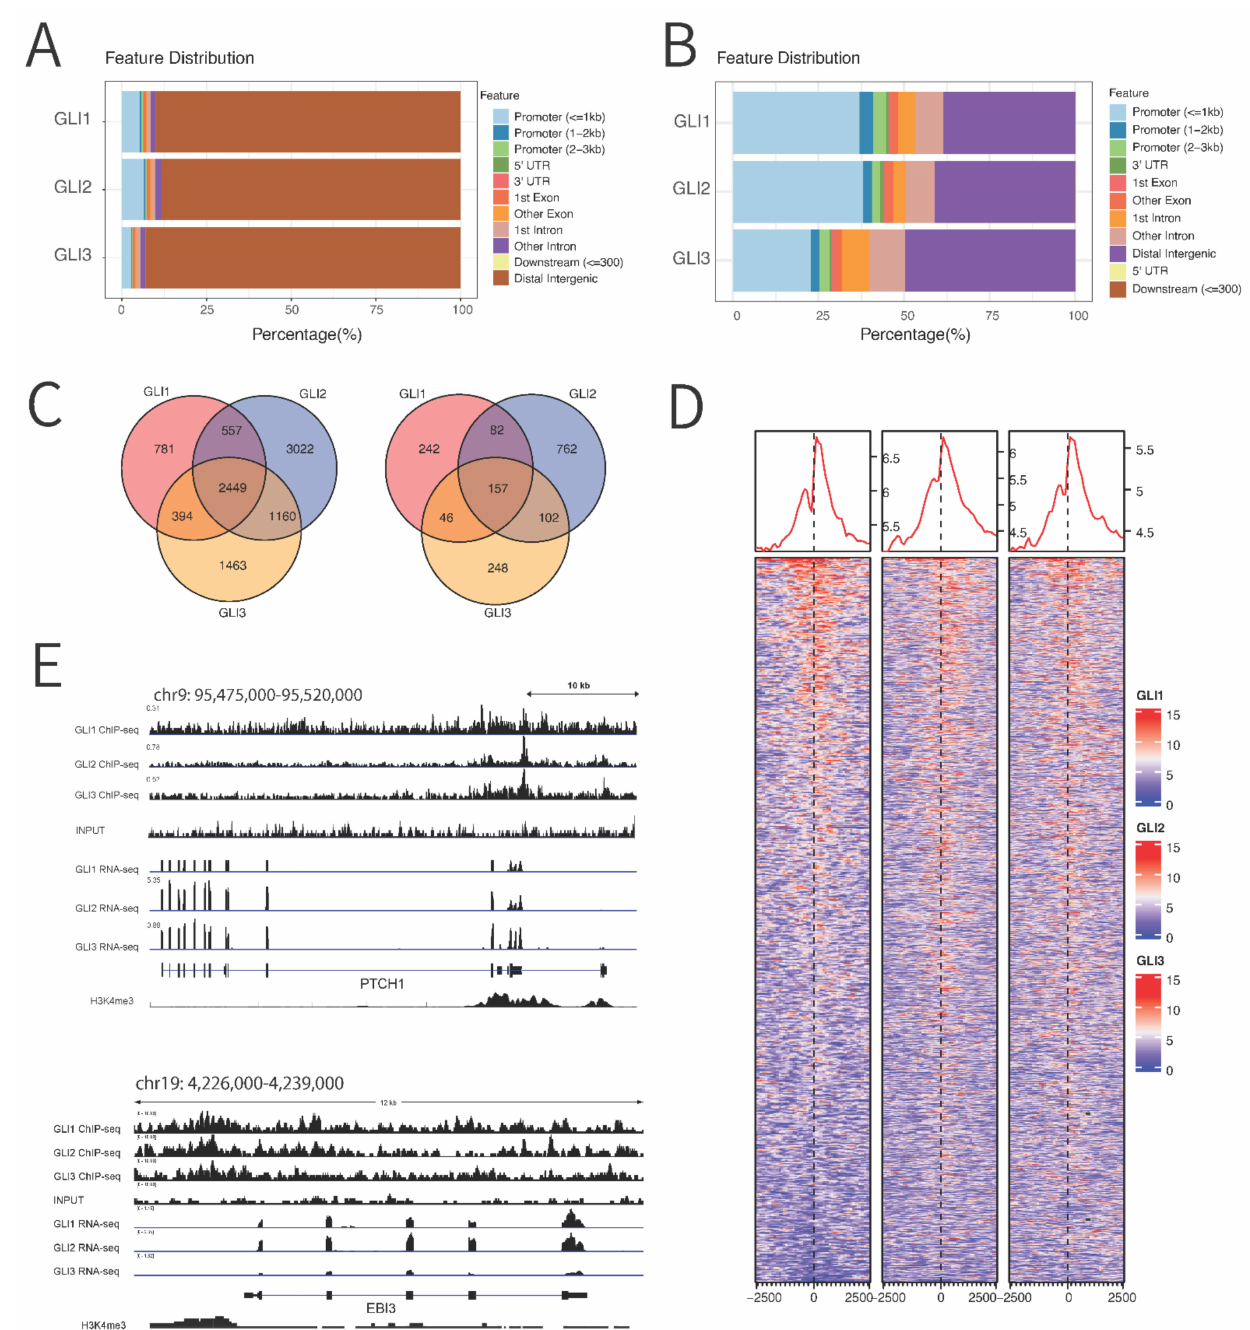
Figure 3. ChIP-seq analysis of GLI1-3 binding across cell lines. ( A ). Binding of peaks on the whole genome. ( B ) Binding of peaks that centered on the promoter regions ( C ) Overlap of GLI1-3 binding sites: left image shows overlapping of peaks on whole genome, and right image shows overlapping of peaks on the promotor regions only. FDR value vas set to 0.2. ( D ) Heatmap of binding of GLI1-3 TFs across promoter sites. ( E ) Peak distribution in PTCH1 and EBI3